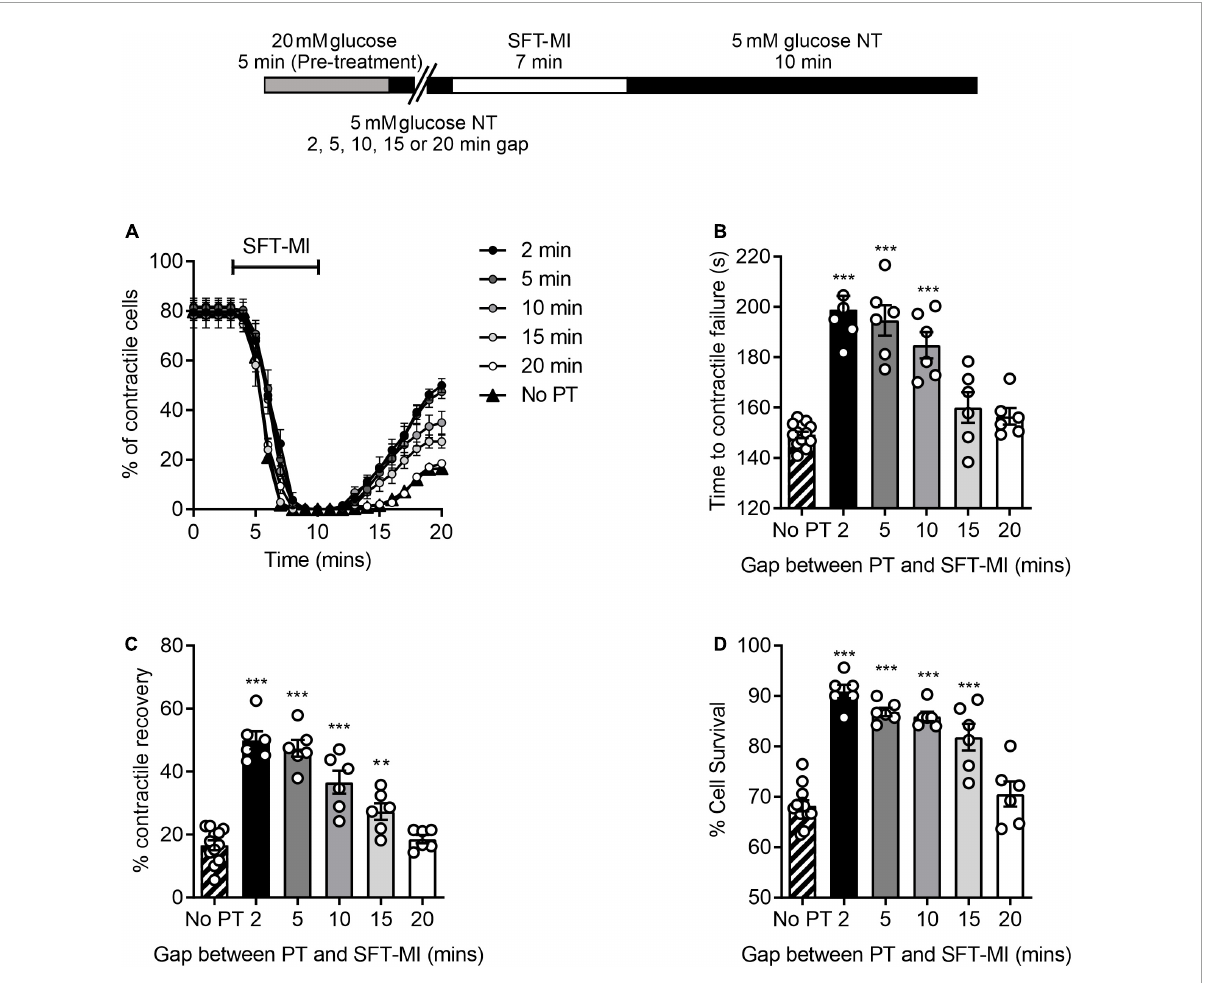
FIGURE4 A 5 min pre-treatment with 20 mM glucose imparts a short-lived cardioprotection. (A) Time course showing the percentage of contractile cardiomyocytes throughout the metabolic inhibition protocol following a 5 min high glucose pre-treatment and a variable gap between the pre-treatment and metabolic insult. (B) Mean time to contractile failure, (C) mean percentage contractile recovery and (D) mean percentage of cell survival [** p < 0.01, *** p < 0.001, One-Way ANOVA with Holm-Sidak post-test. n = 6 experiments from six animals ( > 86 cells for each data